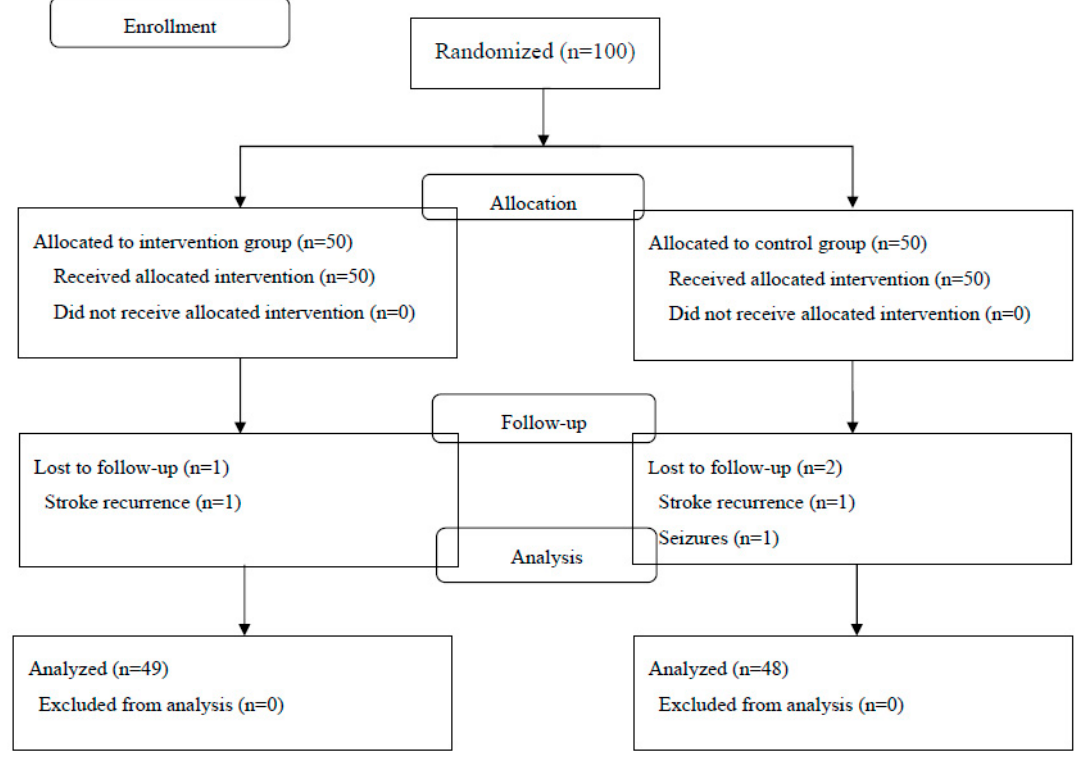
Figure 1. Patient flow diagram.